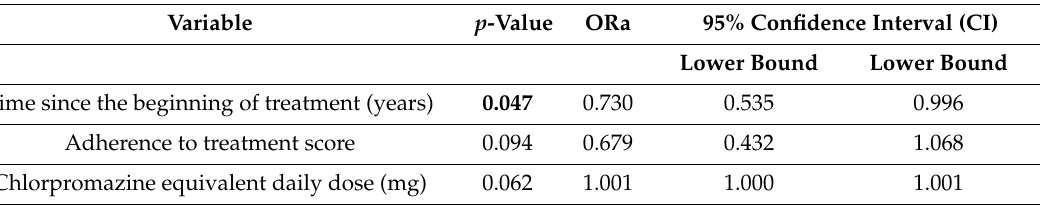
Table 6. Multivariable